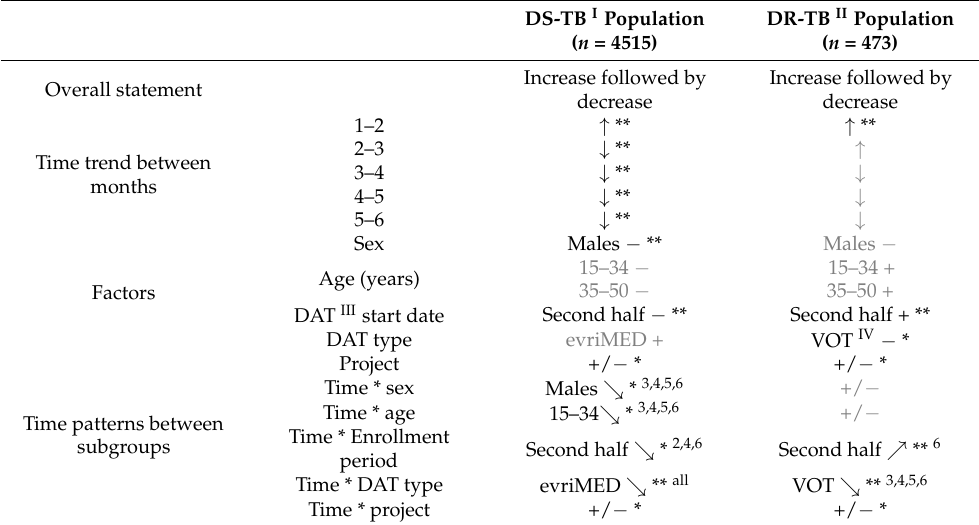
Table 3. Findings of tobit regression analyses; time trend in TB treatment adherence, factors associated with adherence, and differences in time trends across